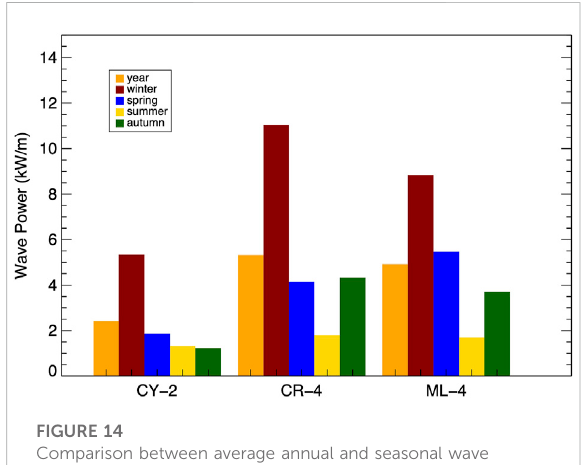
FIGURE 14 Comparison between average annual and seasonal wave power for three of the selected